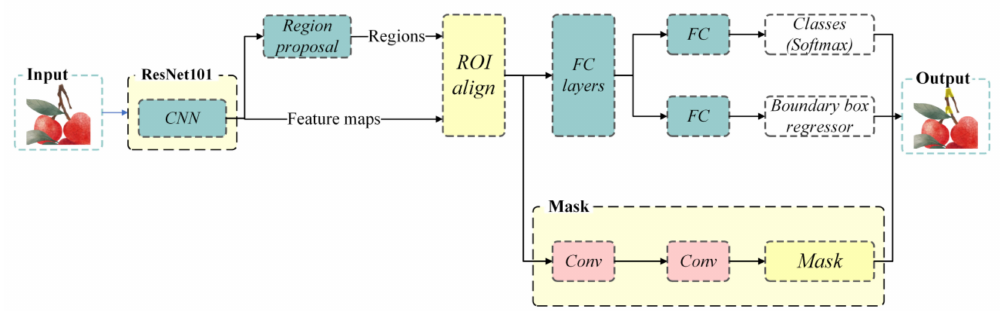
Figure 8. Structure of the MaskRCNN network.